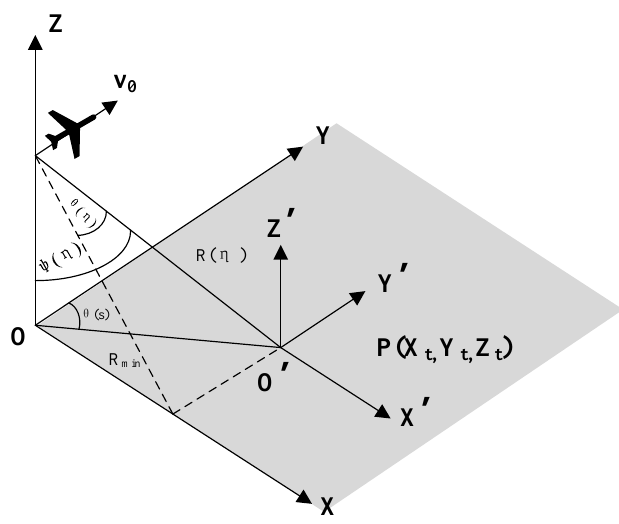
Figure 1. Airborne SAR signal model.